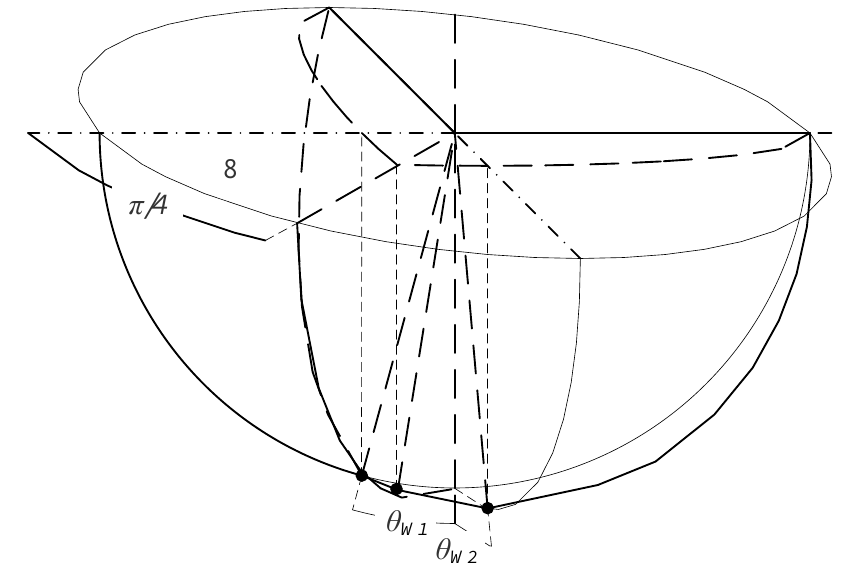
Figure A9. Schematic diagram of block 8 θ W 1 and θ W 2 .